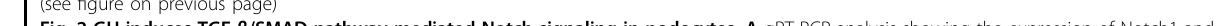
Fig. 2 GH induces TGF- β /SMAD pathway-mediated Notch signaling in podocytes. A qRT-PCR analysis showing the expression of Notch1 and Jag1 in human podocytes treated with or without a conditioned medium (CM; 50%) from podocytes treated with or without GH for 48 h. Mean ± SD. ( n = 6). **** p < 0.0001 by Student ’ s t test. mRNA levels were normalized to β -actin and presented as fold change on the y -axis. B Immunoblotting analysis of podocytes treated with CM (50%) from podocytes treated with or without GH for 48 h. ( n = 3). C Immunoblotting analysis for indicated genes in podocytes treated with or without GH (250 and 500 ng/ml), TGF β -1 (5 ng/ml), GH (500 ng/ml) + SB431542 (100 nM/ml), and GH (500 ng/ml) + AG490 (10 μ M/ml) for 48 h. ( n = 3). n-NICD1 (nuclear-NICD1), n-HES1 (nuclear HES1), and n-HEY1(nuclear HEY1). D Podocytes transfected with siRNA targeting TGFBR1 or scramble RNA (Scr-RNA) were subjected to immunoblotting for indicated genes. ( n = 3). E Immuno fl uorescence for the nuclear colocalization of NICD1 (red color), HES1 (purple color), and counterstained with DAPI (blue color) in podocytes treated with or without GH for 48 h. Magni fi cation ×630. Scale bar = 20 μ m. ( n = 3). F HES1 reporter activity was measured in podocytes exposed to GH for 48 h. Mean ± SD. G qRT-PCR analysis for Notch1 and JAG1 in podocytes isolated from a mouse treated with or without GH (1.5 mg/kg b.w), GH + SB431542 (1 mg/kg b.w), and GH + AG490 (1 mg/kg b.w). Mean ± SD. ( n = 6). F , G **** p < 0.0001 by one-way ANOVA post hoc Dunnett test ( n = 6). H Representative immunoblots for indicated genes in podocytes isolated from mice treated with or without GH. ( n = 3). β -Actin and lamin-B1 served as an